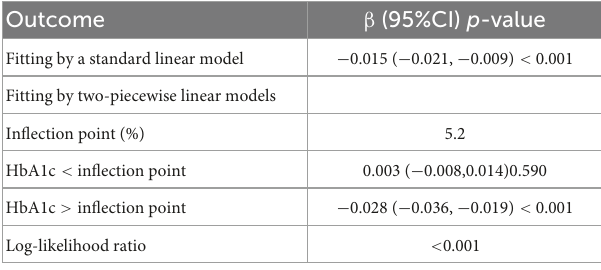
TABLE 6 Two piecewise model for relation between hemoglobin and ASM BMI in non-T2DM male population. Outcome Fitting by a standard linear